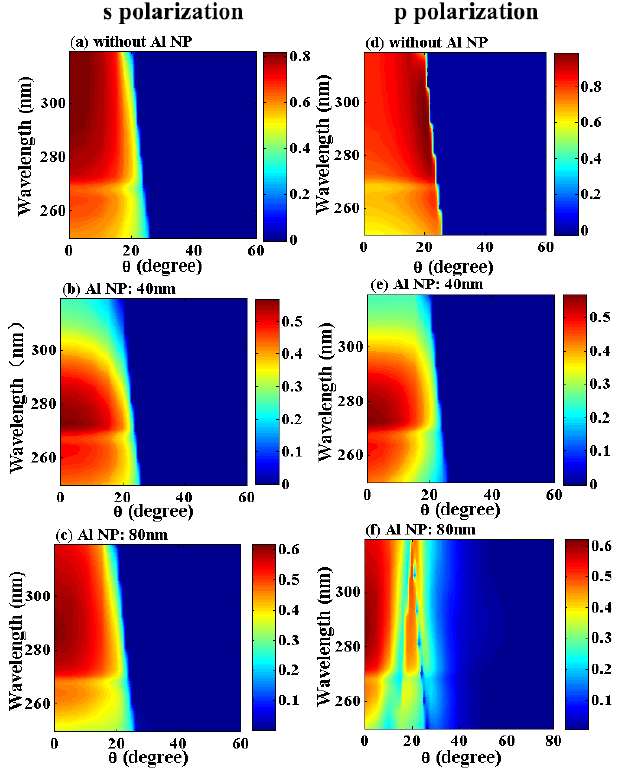
Figure 3. The transmission spectra of ( a , d ) c-LED and ( b - c , e - f ) SP-LED as a function of θ for s- and p-polarizations. For SP-LED, the diameter of Al NPs is set to ( b , e ) 40 nm and ( c , f ) 80 nm, respectively.